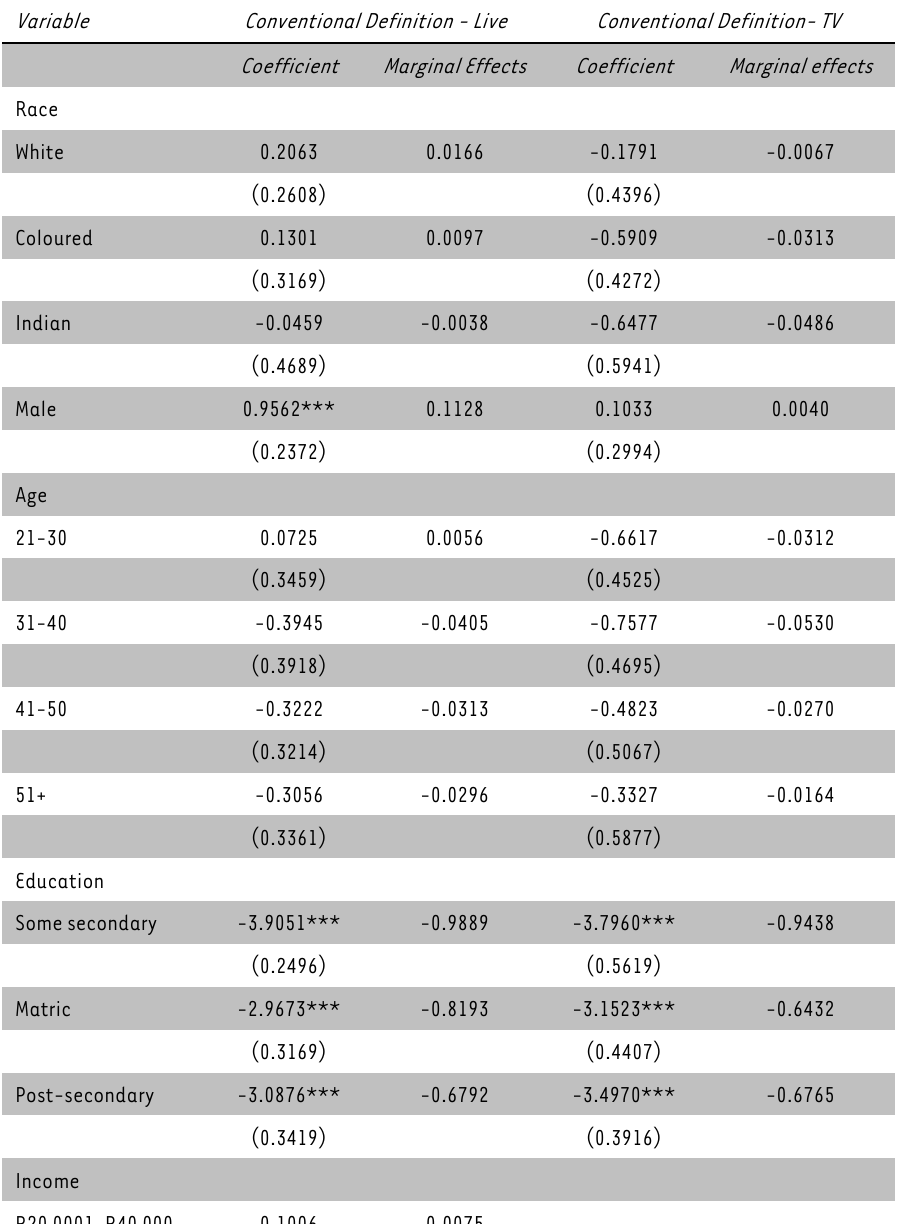
TABLE 3: Probit results predicting the probability of a univore classification (conventional